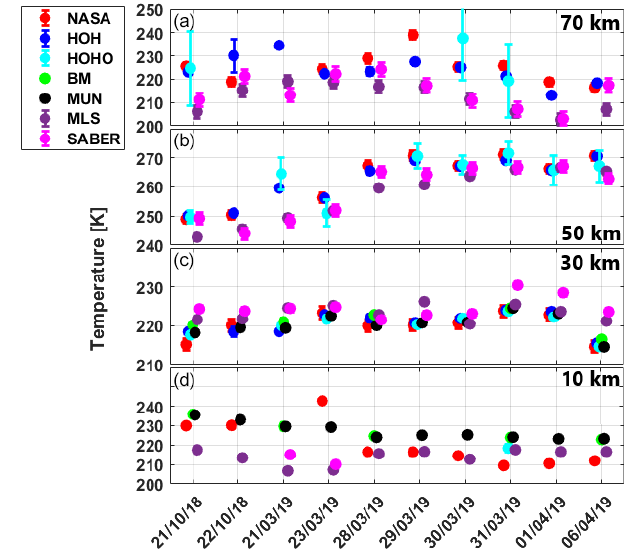
Figure 9. Time series of temperature measurements at smoothed using a 2km boxcar average. Panel (a) contains temperatures at 70km, panel (b) at 50km, panel (c) at 30km, and panel (d) at